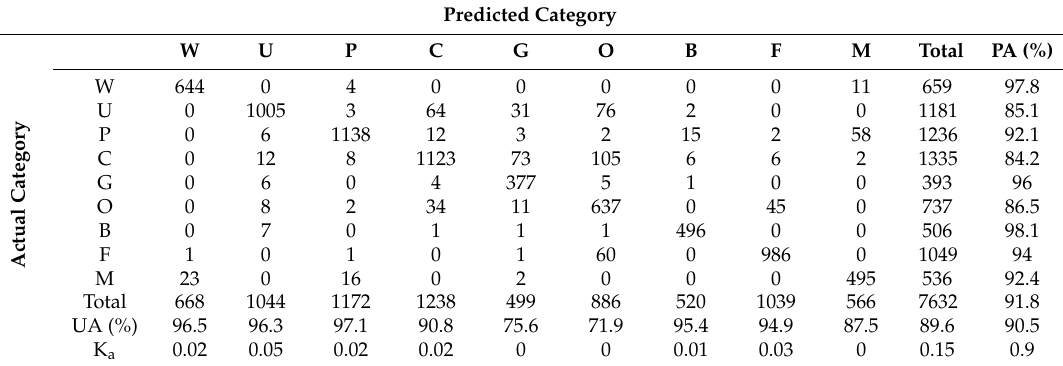
Figure 3. Land cover maps in ( a ) 2007, ( b ) 2017, ( c ) areas of land cover change within the 10-year period over Central Vietnam, and A, B, and C are the selected sites for change analysis in Thua Thien Hue, Quang Nam, and Thanh Hoa provinces, respectively. Table 4. Accuracy assessment of the 2007 land cover maps over Central Vietnam, using a confusion matrix.